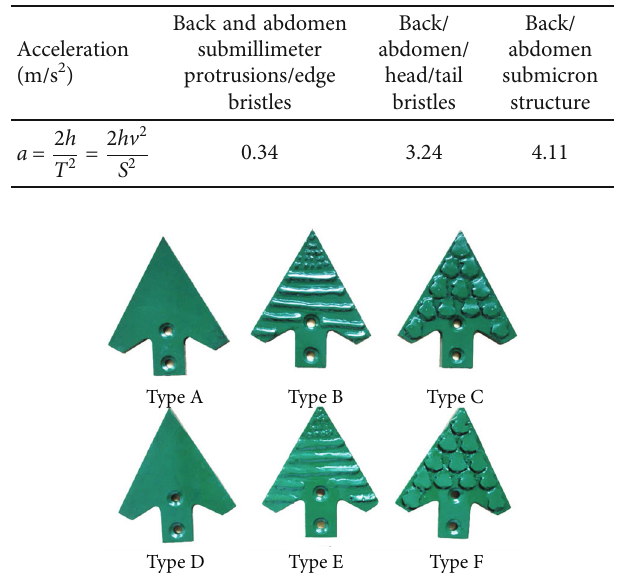
Figure 8: Six types of subsoiler shovel